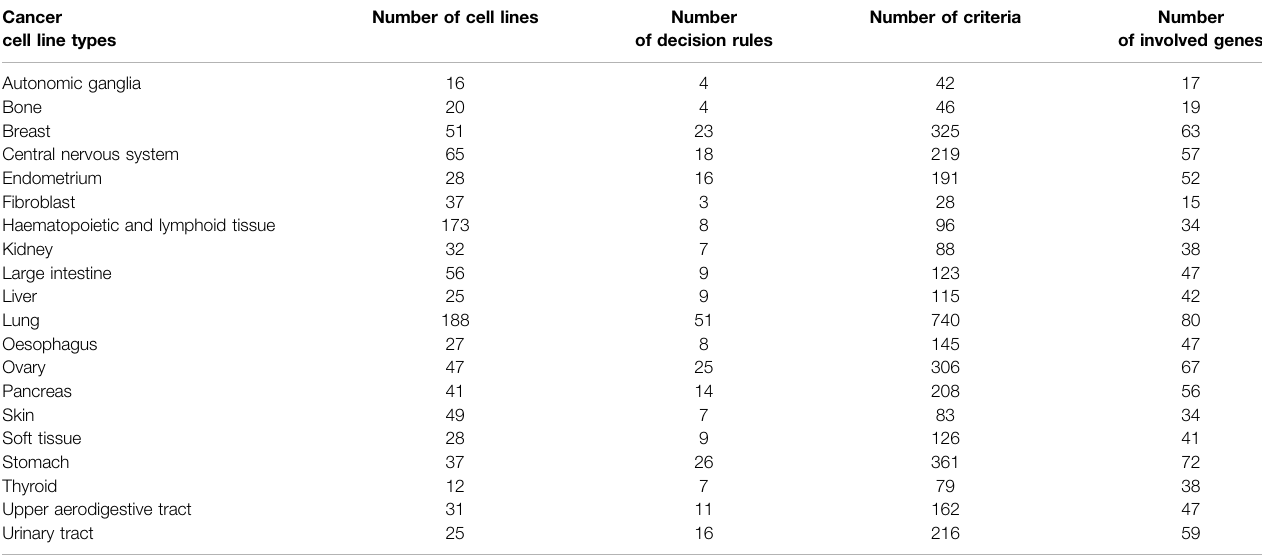
TABLE 1 | Distribution of samples and decision rules in different cancer cell lines. Cancer cell line